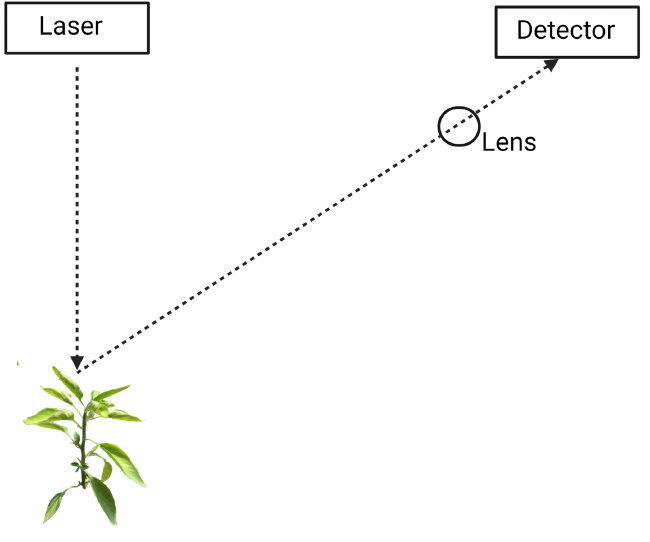
Figure 3. General configuration of laser